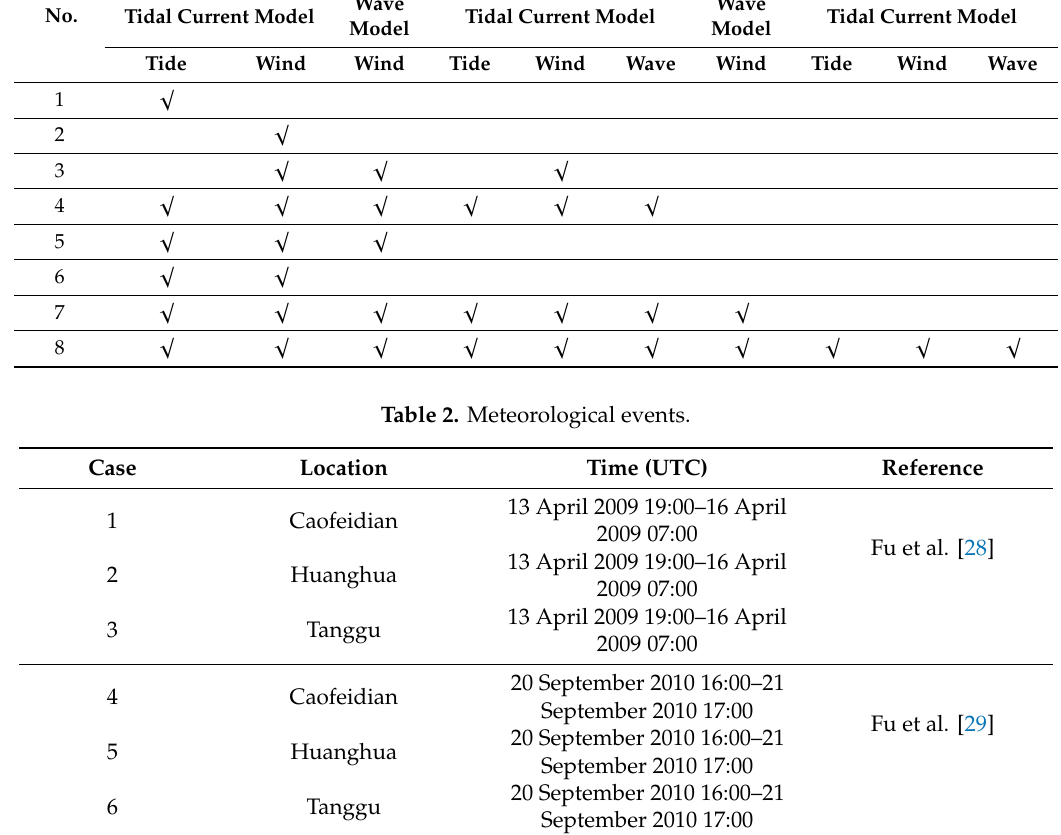
Figure 2. Flow chart for coupling the tidal current and wave models. Table 1. Runs of simulations and the setup for sub-models. force that are considered. The final output of the run comes from the last used sub-model. Run No.